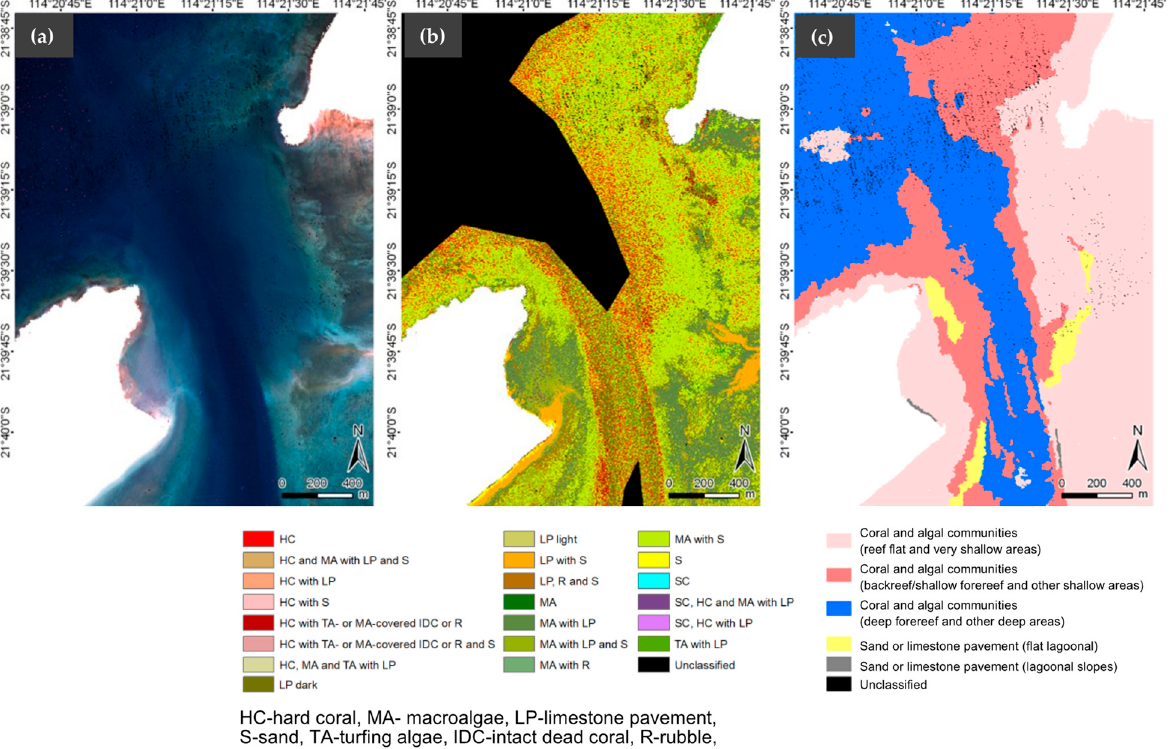
Figure 11. Muiron Islands area ( a ) subsurface reflectance, ( b ) pixel-based benthic habitat map and ( c ) geomorphic classes for the same area.